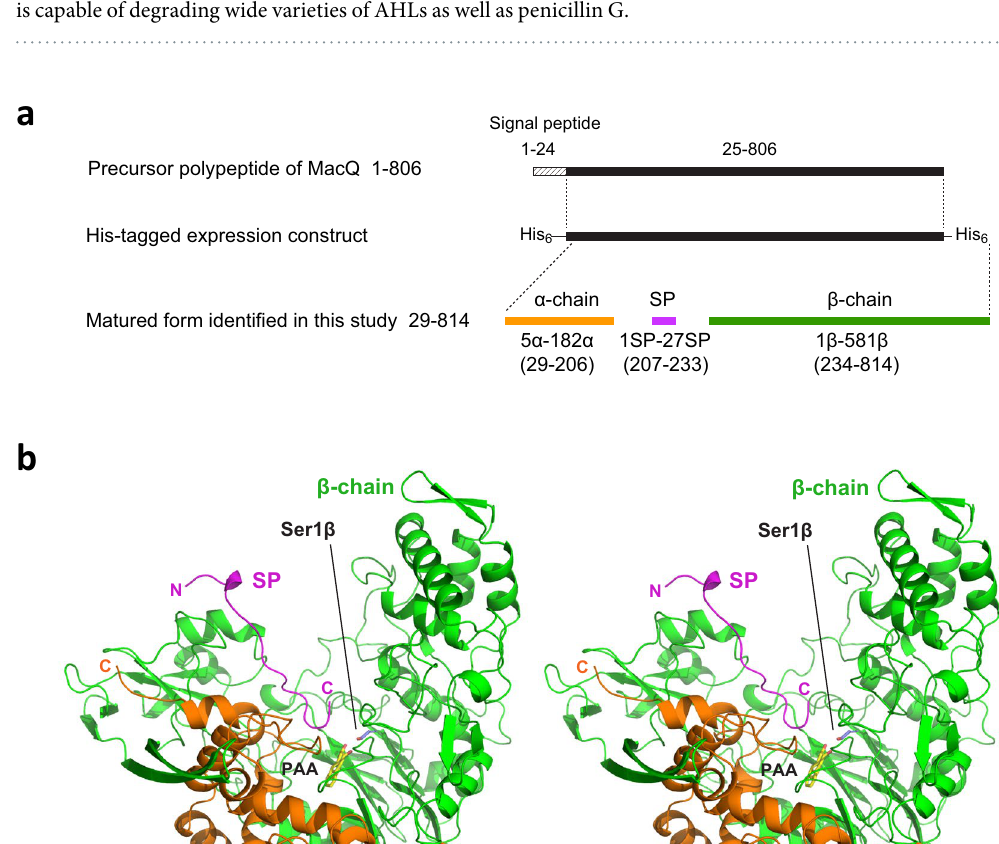
Figure 1. Amidohydrolysis of AHL (C 10 -HSL) and penicillin G catalyzed by MacQ. As shown in Table 1, MacQ is capable of degrading wide varieties of AHLs as well as penicillin G.